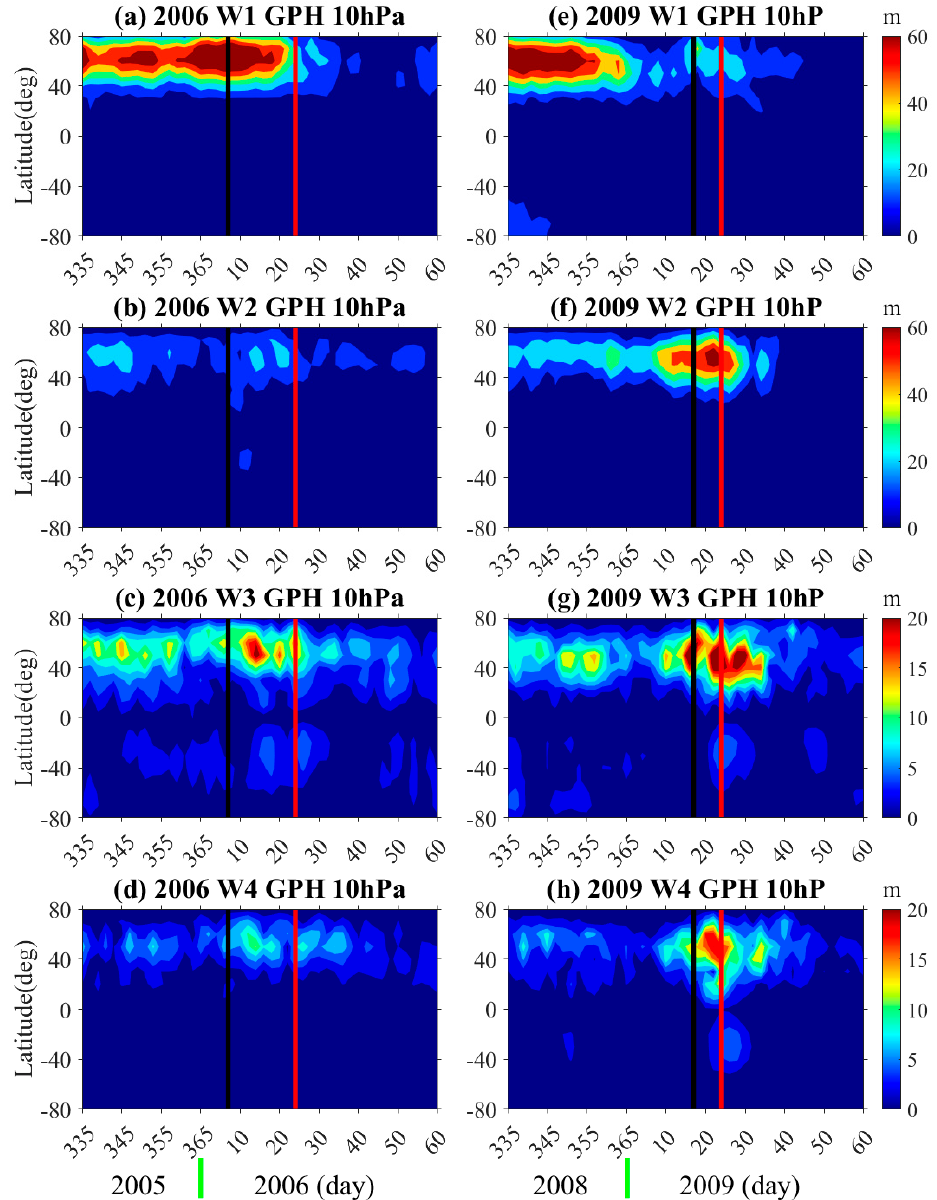
Figure 6. Temporal and latitude variation of the GPH in 2006 ( a – d ) and 2009 ( e – h ). The vertical black and red lines indicate the starting of the sudden stratospheric warming and the warming peak of the sudden stratospheric warming.